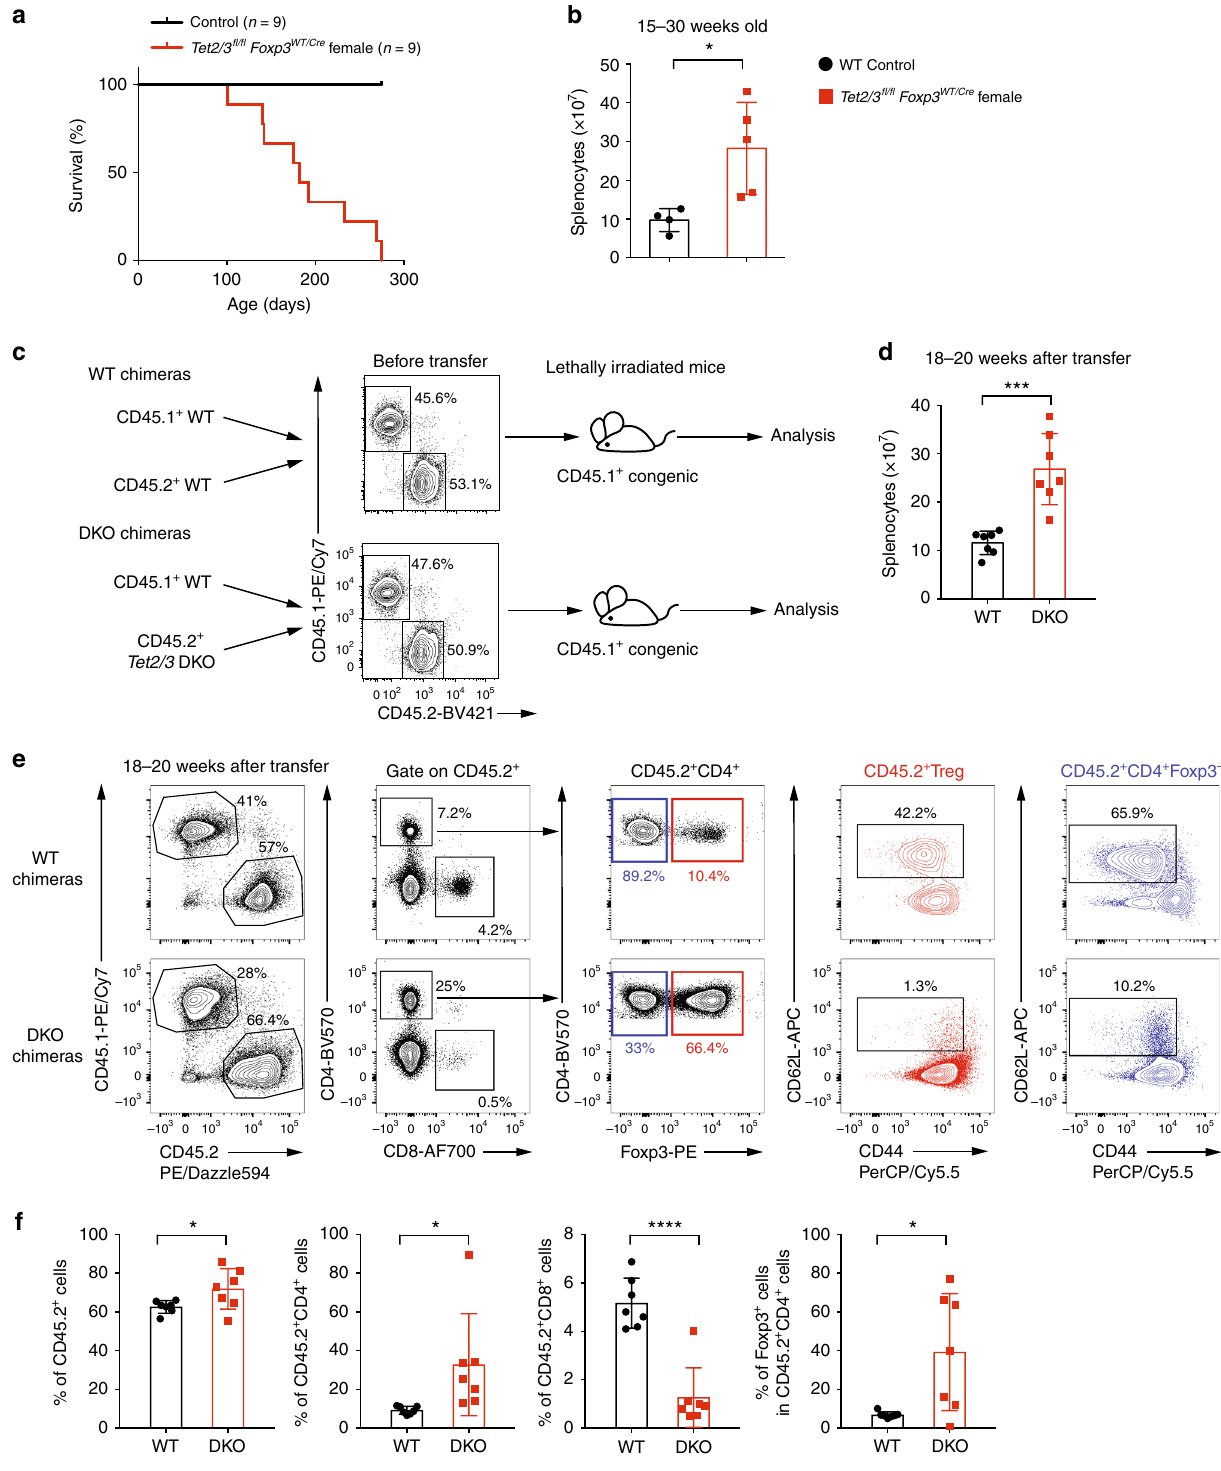
Fig. 5 WT Treg cells fails to rescue the in fl ammatory phenotype of Tet2/3 fl / fl Foxp3 Cre mice. a Survival curves for control WT ( n = 9) and Tet2/3 fl / fl Foxp3 WT/Cre heterozygous female ( n = 9) mice. b Total cell numbers in spleen from WT and Tet2/3 fl / fl Foxp3 WT/Cre heterozygous female mice (15 – 30 weeks-old, n = 5). c Schematic illustration for the generation of mixed bone marrow chimeras. The fl ow cytometry plots show the ratios of WT CD45.1 + congenic bone marrow cells and co-transferred CD45.2 + WT or Tet2/3 DKO bone marrow cells immediately prior to transfer. d Total cell numbers in spleen from WT and Tet2/3 DKO mixed bone marrow chimeras with splenomegaly ( n = 7) 18 – 20 weeks after transfer. e Representative fl ow